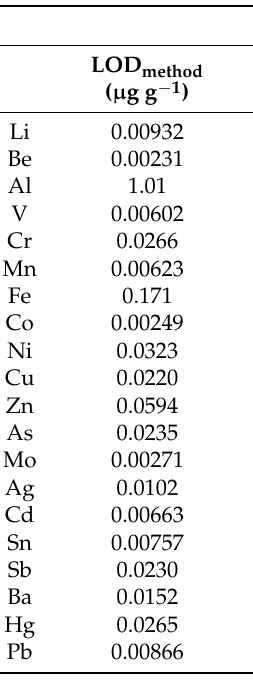
Table 3. Methodology